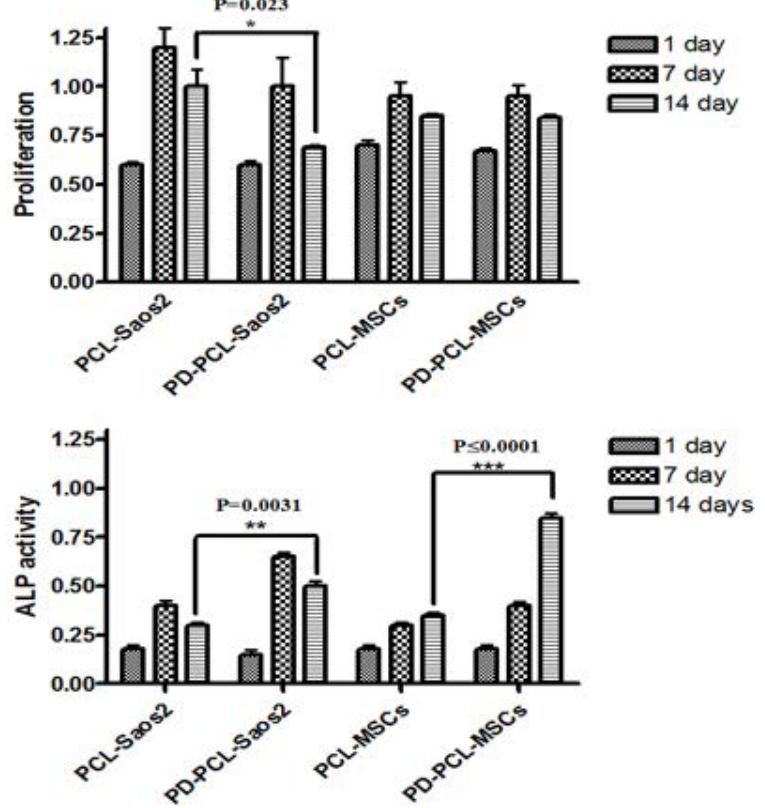
Figure 3. Cell proliferation and alkaline phosphatase activity of Saos-2 and MSC cell lines seeded on both PCL and PD-PCL scaffolds. * p ≤ 0.05; ** p ≤ 0.005; *** p ≤